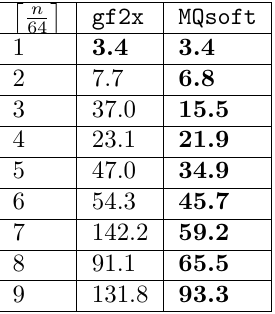
Table 6: Number of cycles to multiply two elements of F 2 [ X ] of degree n − 1. We use a Skylake processor